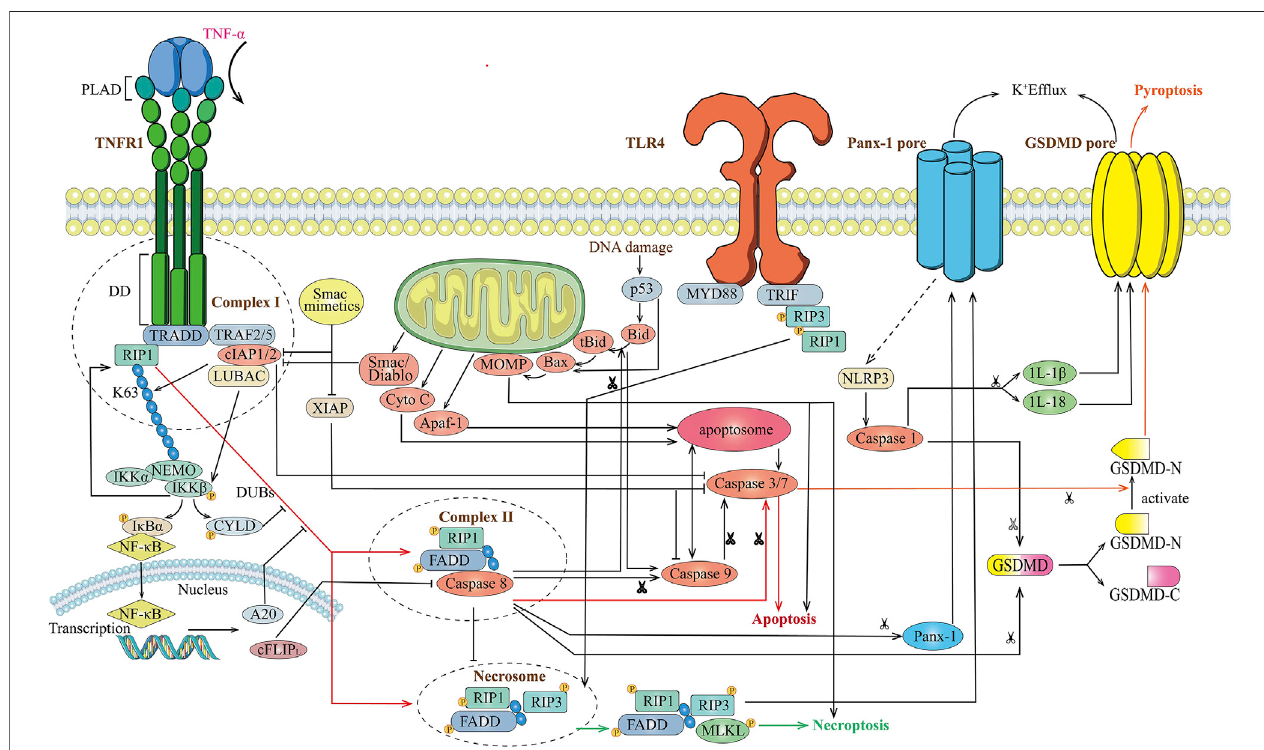
FIGURE 1 | OverviewofTNF-induced different celldeath signaling mode. Stimulation ofcells withTNF leads torecruitment ofTRADD and RIP1 toTNFR1, and forms complexI withTRAF2/5,cIAP1/2.The ubiquitination ofRIP1resultsinIKK-mediated activationofNF- κ B and de-ubiquitination ofRIP1 results information ofcomplexIIwith FADD and caspase-8, then activates caspase-3 and caspase-7 leading to apoptosis. Meanwhile activated caspase-8 cleaves Gasdermin to form the N-terminal domain (GSDM-N)andC-terminaldomain(GSDM-C),whichconvertapoptosistopyroptosis.A20andCYLDblockthede-ubiquitinationofRIP1blockformationofComplexII and apoptosis. Upon inhibition of caspase-8, RIPK1 activates RIPK3 leading to the formation of the necrosome, which ultimately leads to necroptosis.